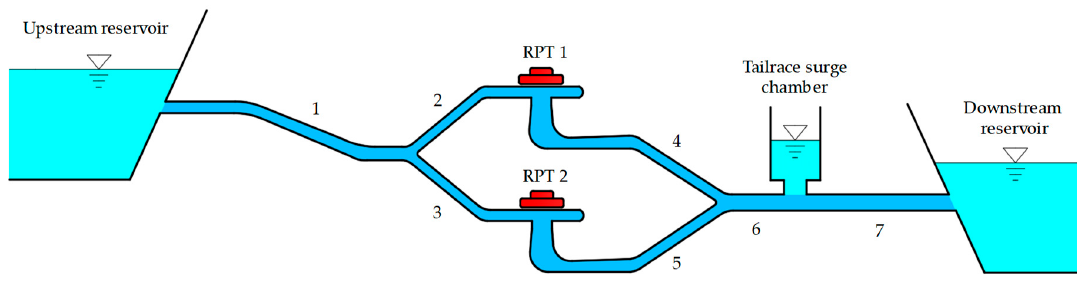
Figure 2. Schematic of a typical pumped storage plant system.